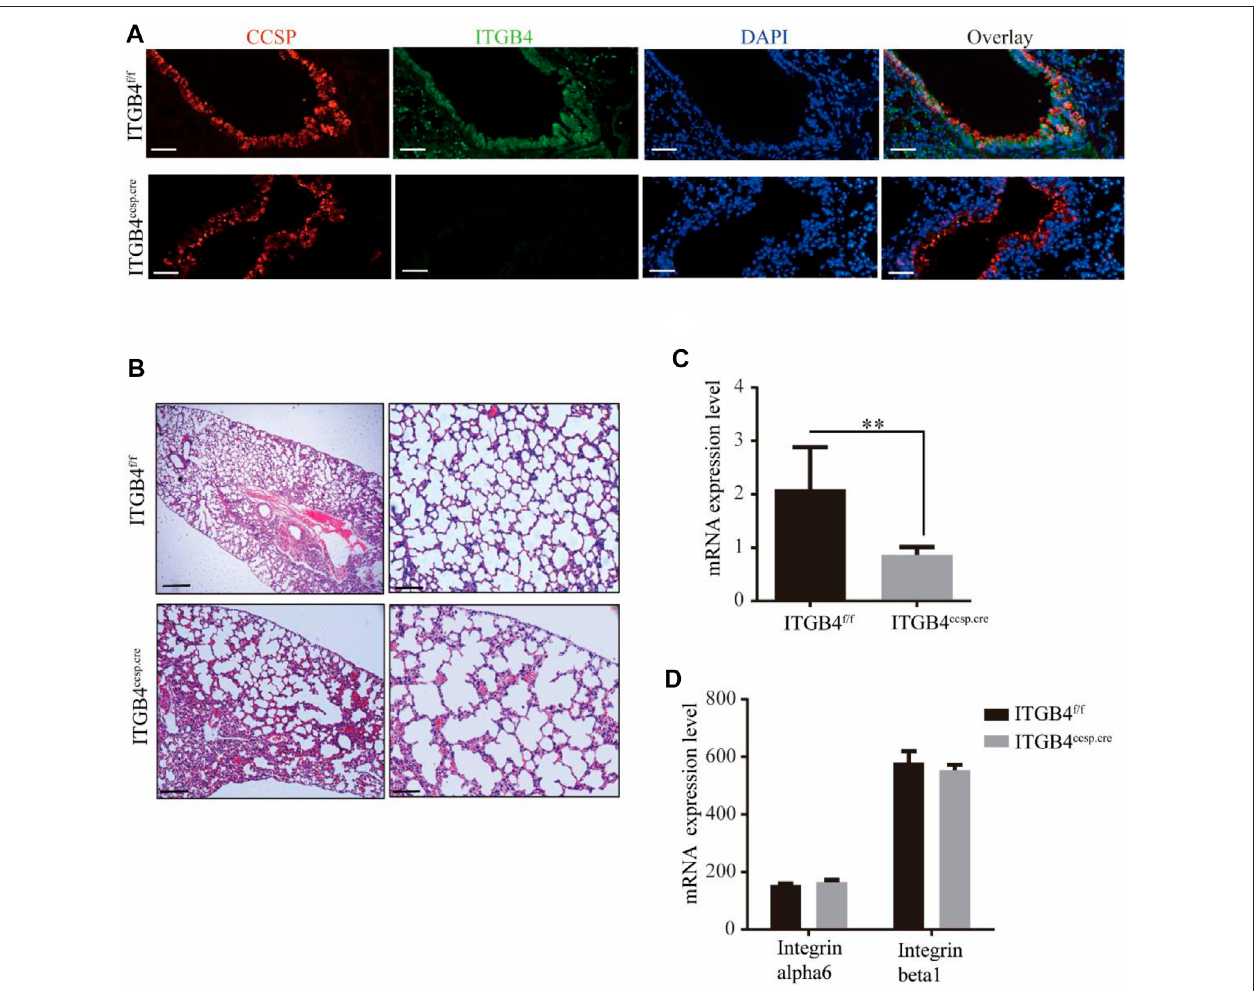
FIGURE 1 | Silencing ef fi ciency of ITGB4 and lung structure of ITGB4 f/f and ITGB4 ccsp.cre mice. (A) ITGB4 expression was detected by conducting immuno fl uorescence. CCSP (red) and ITGB4 (green) were performed in lung sections. DAPI was used to stain cell nuclei (blue).Scale bars: 50 μ m (B) Dilated airspaces withthickened alveolarseptawereseeninH&E-stained paraf fi nsectionsofP28lungs. (Scalebars:250 μ mforleftand50 μ mforright) (C,D) RT-PCRanalysisofITGB4, integrin alpha6, integrin beta1 mRNA expression levels in ITGB4f/fand ITGB4ccsp.cre mice. (** p < 0.01 ). Data are presented as mean ± SD.